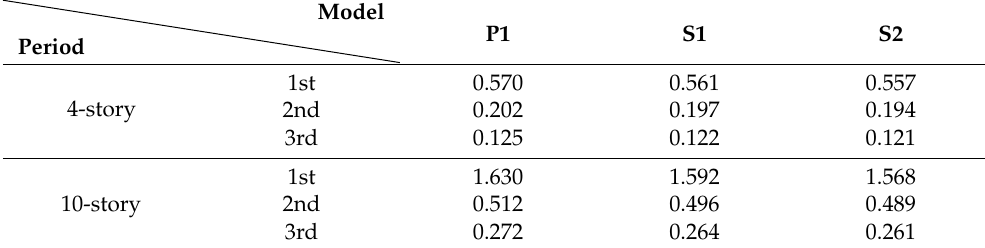
Table 8. Corresponding period of different-order vibration modes of CBF models (unit: s).